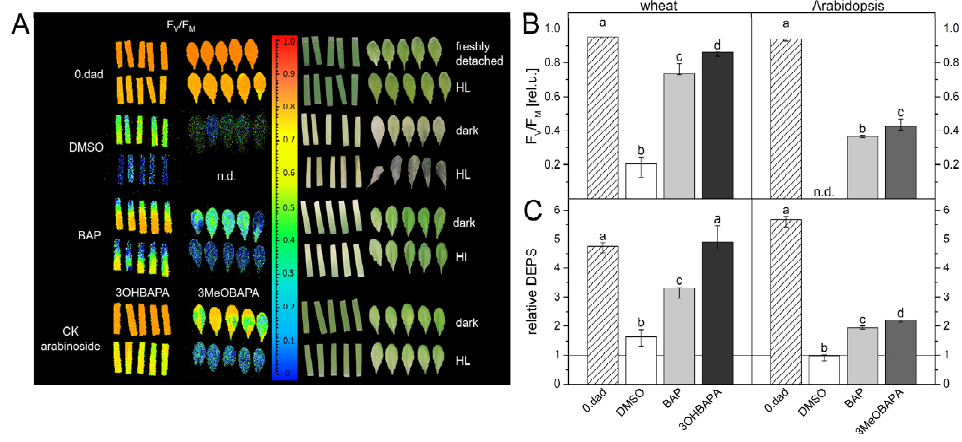
Figure 9. ( A ) Imaging of maximum quantum yield of PSII photochemistry (F V /F M ) before and after high-light treatment (HL; 500 µmol photons·m − 2 ·s − 1 for 4 h) of freshly detached leaves and leaves incubated for 6 days in 0.1% DMSO or 10-µmol·L − 1 solutions of BAP, 3OHBAPA or 3MeOBAPA; ( B ) the relative F V /F M values and ( C ) relative de-epoxidation state of xanthophylls (DEPS) in detached wheat and Arabidopsis leaves. The relative F V /F M and DEPS were calculated as a ratio of values measured after and before exposure to high light. In the column graphs, medians and quartiles estimated from presented values of individual leaves are shown ( n = 5). Different letters indicate a statistically significant difference between treatments within a plant species ( p < 0.05; Student’s unpaired t -test). In Arabidopsis, the xanthophyll cycle was only moderately stimulated in the